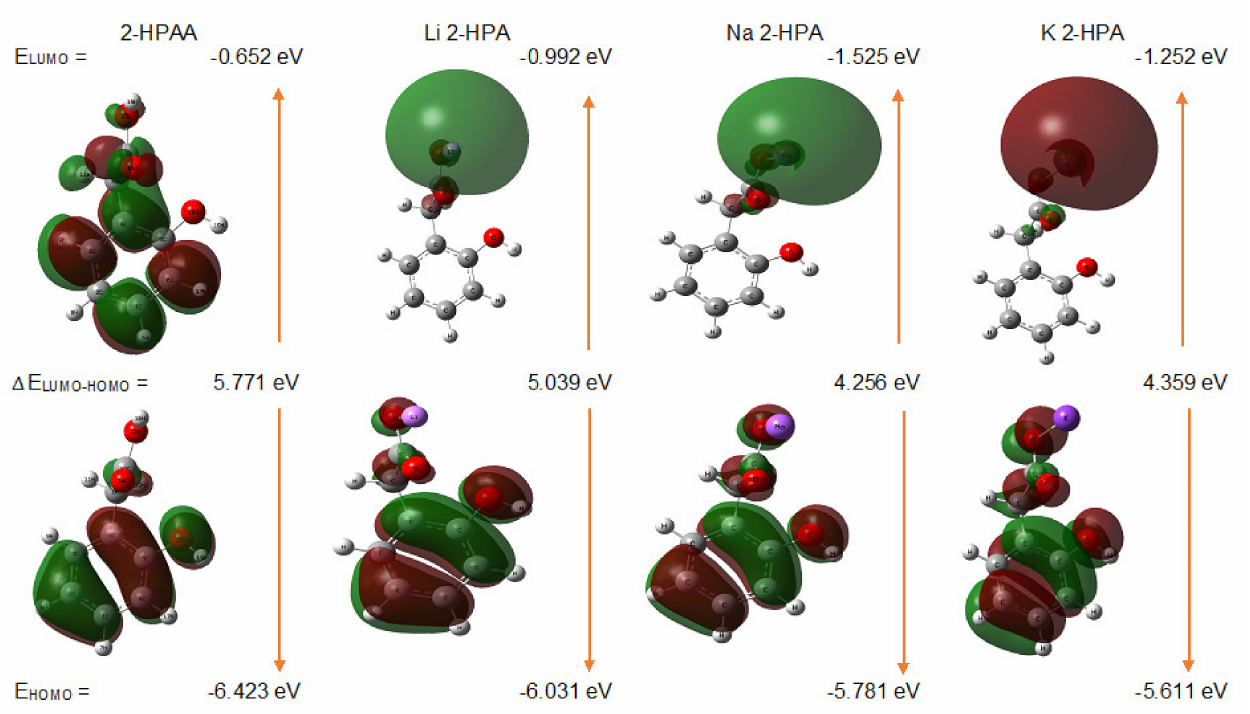
Figure 5. The atomic orbital components of the frontier molecular orbital of 2-hydroxyphenylacetic acid (2-HPAA) and their lithium (Li 2-HPA), sodium (Na 2-HPA), and potassium (K 2-HPA)